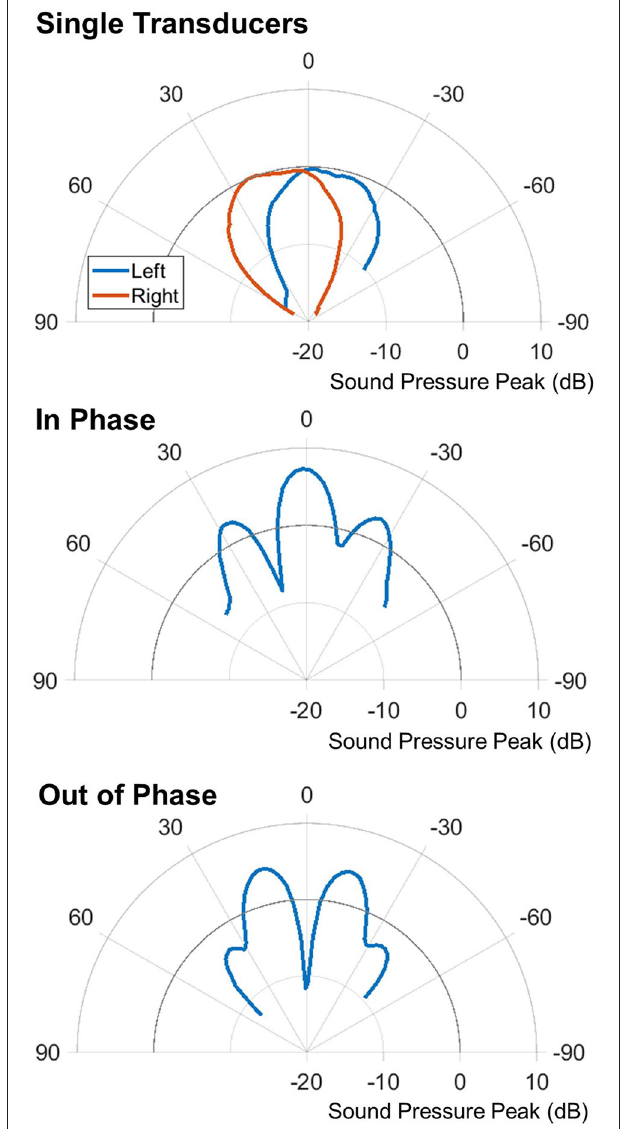
FIGURE 11 | Polar plots of the different firing patterns. Top shows single transducer pulses from the left and right transducers. Middle shows the synchronous in-phase firing pattern. Bottom shows the synchronous out-of-phase firing